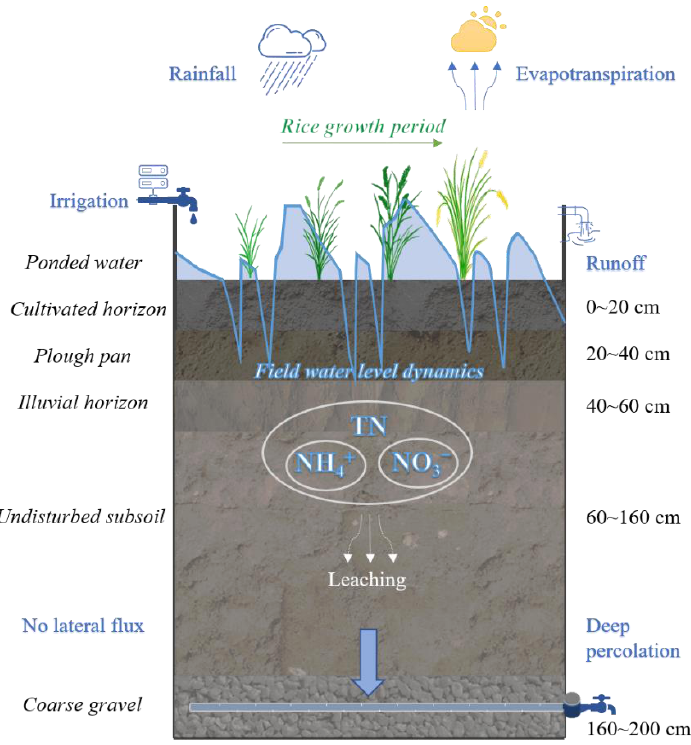
Figure 1. Schematic of the soil profile and water balance components of lysimeter experiments.